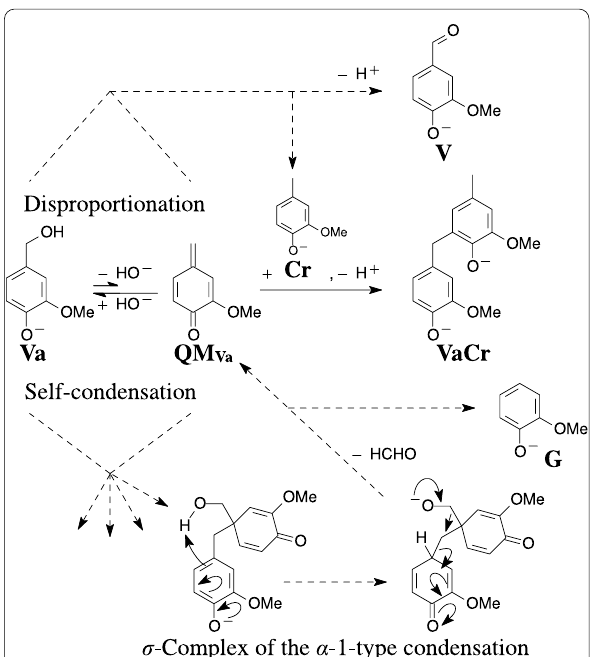
Fig. 3 Possible reactions suggested to progress in this work. Dotted lines show reactions whose occurrences have not completely been